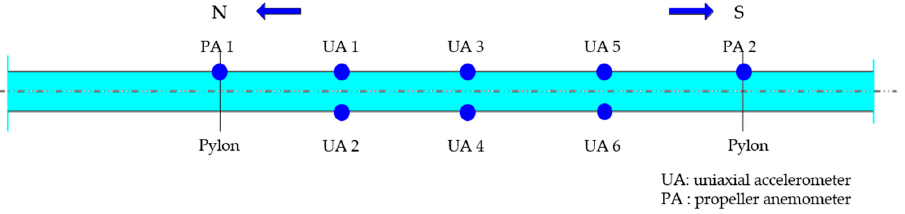
Figure 12. Anemometers in XHM Bridge: ( a ) Ultrasonic anemometers; ( b ) propeller anemometer.